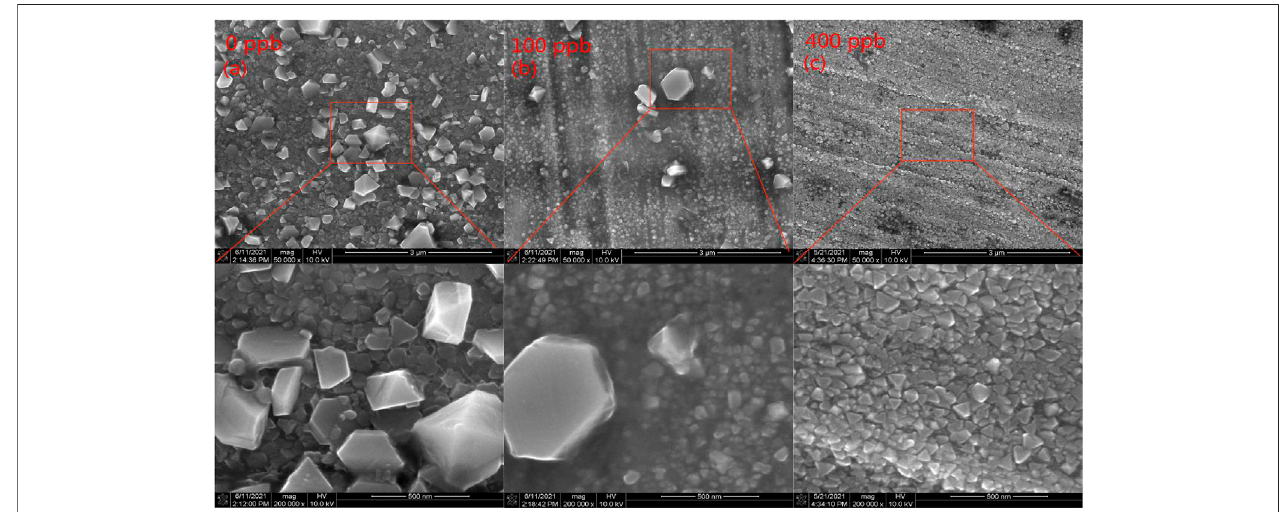
FIGURE 1 | The surface morphology of 304SS after exposure to different zinc concentrations at: (A) 0 ppb (B) 100 ppb (C) 400 ppb.